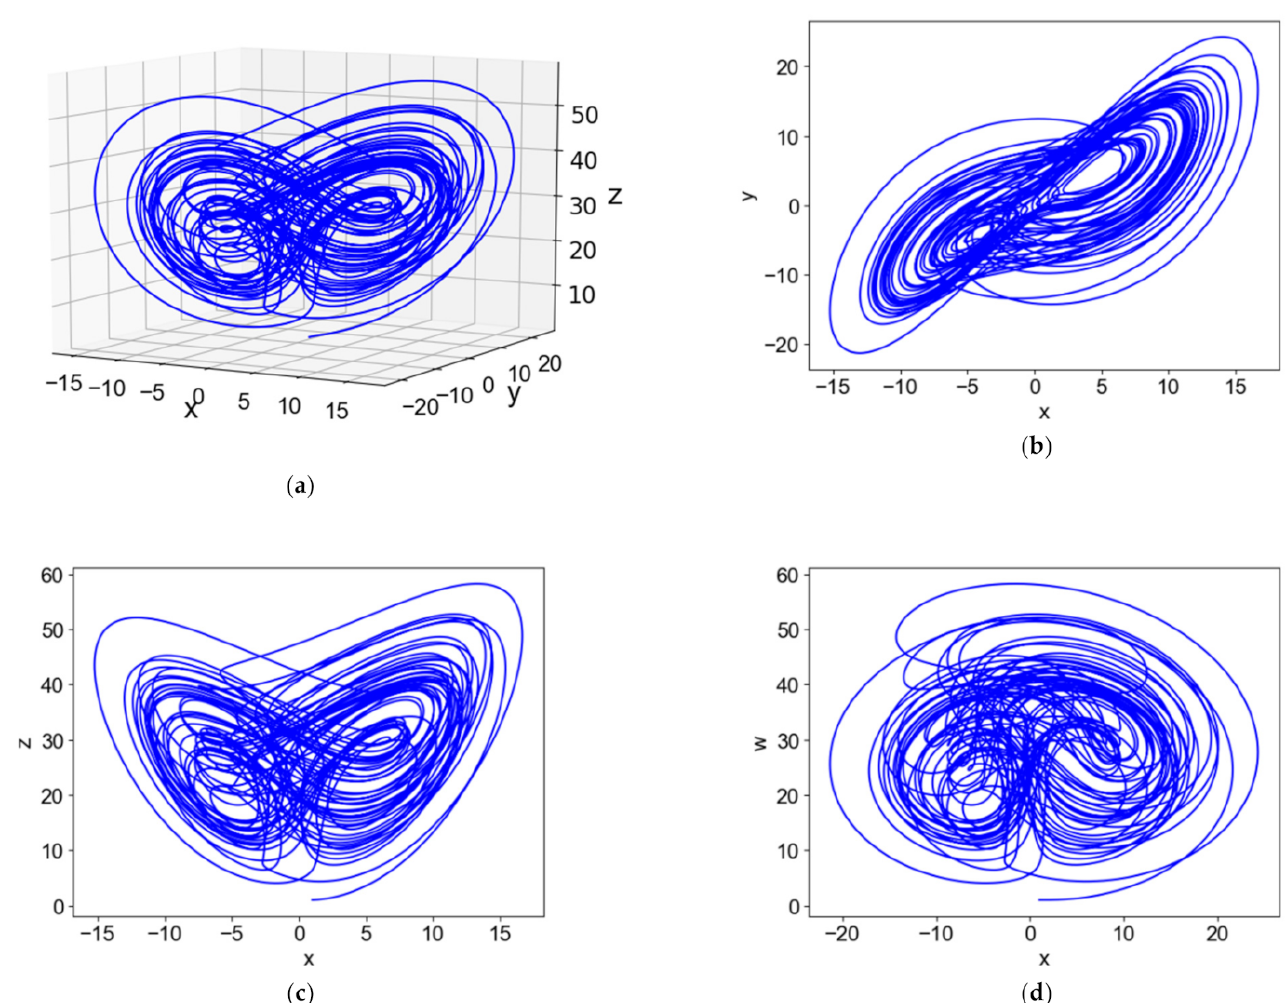
Figure 2. Phase portraits of the 4-D hyperchaotic system with system parameters of a = 10, b = 28, c = 8/3, d = 1, and e = 16 and initial values of (1, 1, 1, and 1). ( a ) Projection on x-y-z plane; ( b ) projection on x-y plane; ( c ) projection on x-z plane; ( d ) projection on x-w